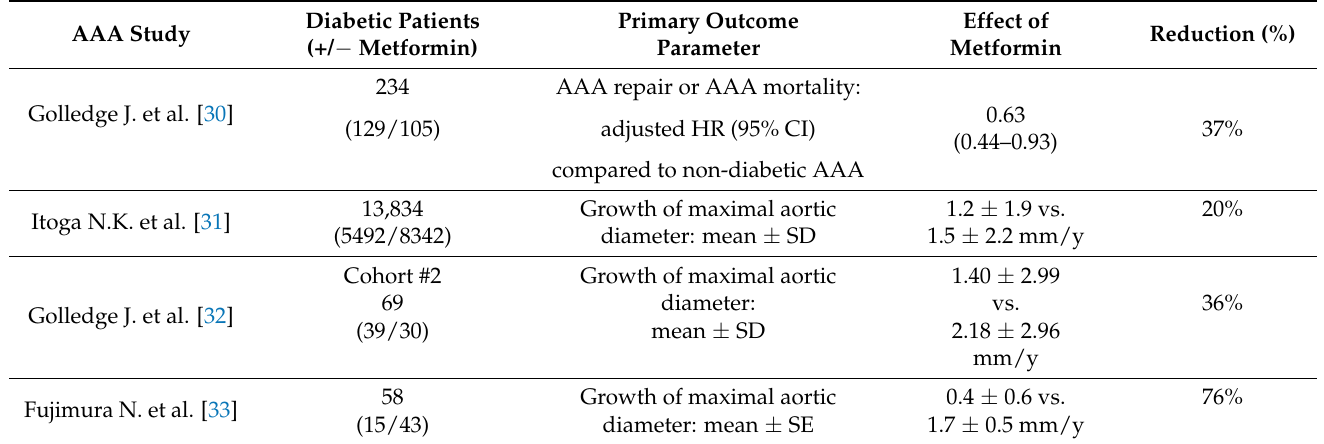
Table 1. Summary of retrospective analyses on aneurysm progression and AAA related clinical events comparing diabetic AAA patients with and without metformin therapy (95% CI, 95% confidence interval; HR, hazard ratio; SD, standard deviation; SE, standard